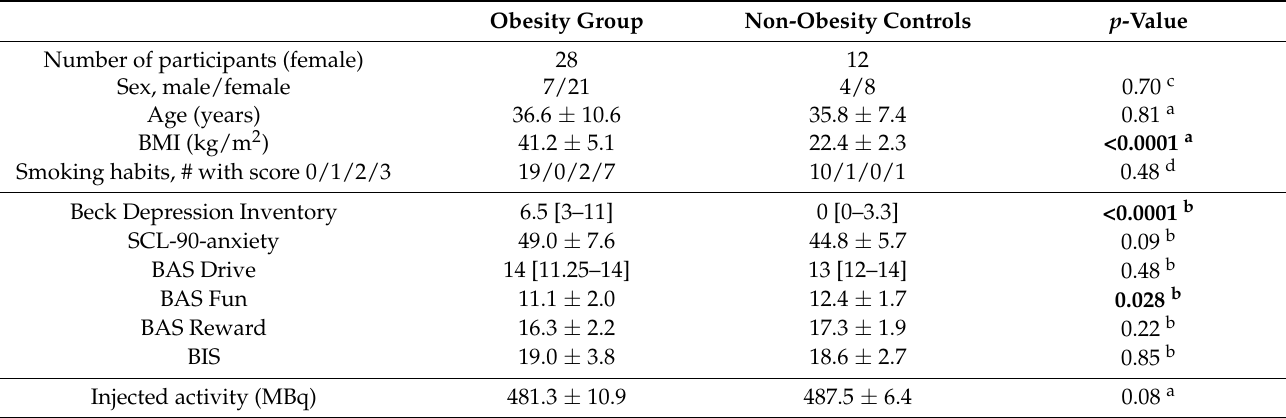
Table 1. Participant characteristics, questionnaires and seasonal data.